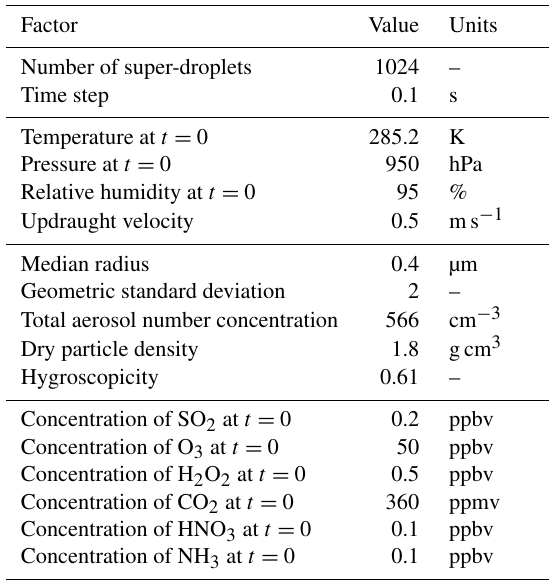
Table 1. Initial conditions for the adiabatic parcel